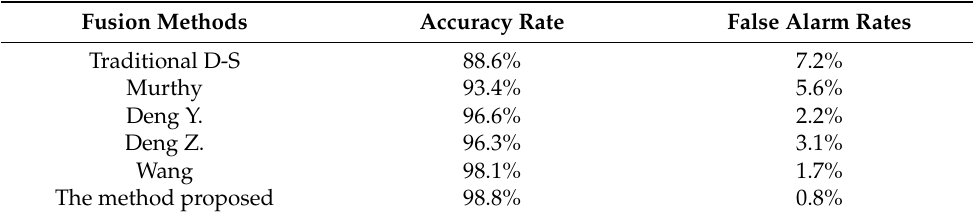
Table 11. Comparison of fire detection accuracy and false alarm rate of different methods. Fusion